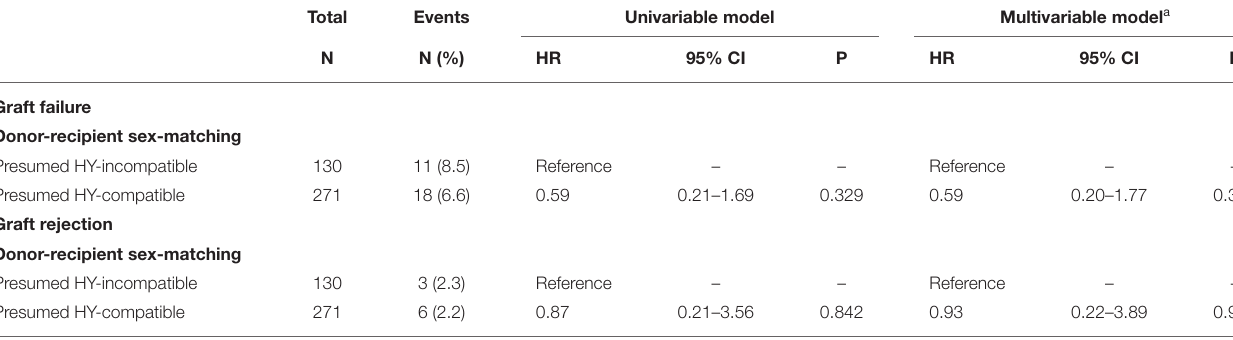
TABLE 2 | Associations of donor-recipient sex-matching with graft failure and rejection.